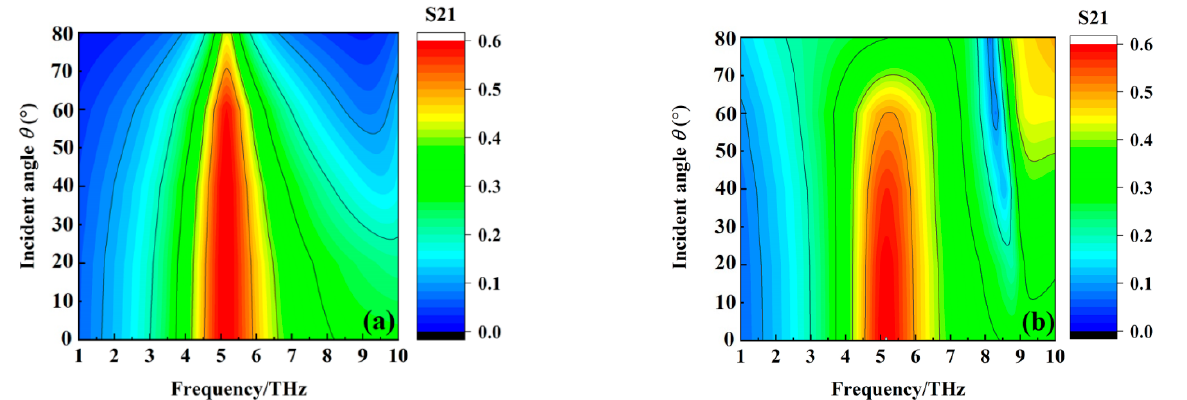
Figure 10. The transmission coefficient of the metamaterial absorber when the conductivity of VO 2 film is 10 S/m at different incident angles at TE and TM mode. ( a ) TE mode; and ( b )TM mode.